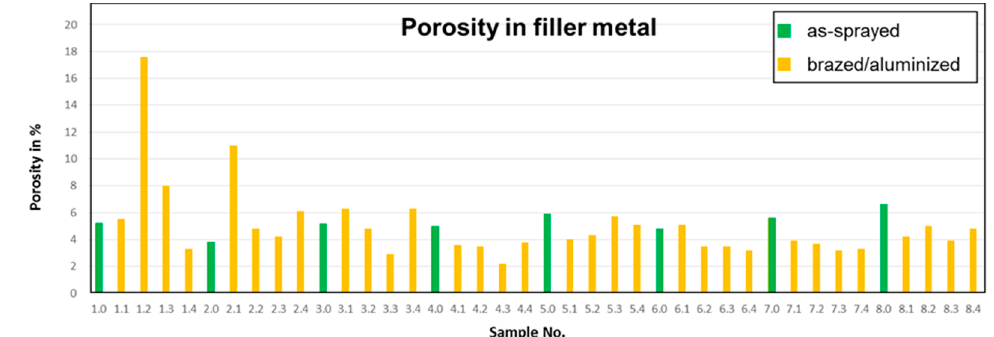
Figure 4. Porosity in filler metal for different samples in the as-sprayed condition and after the heat-treatment process.